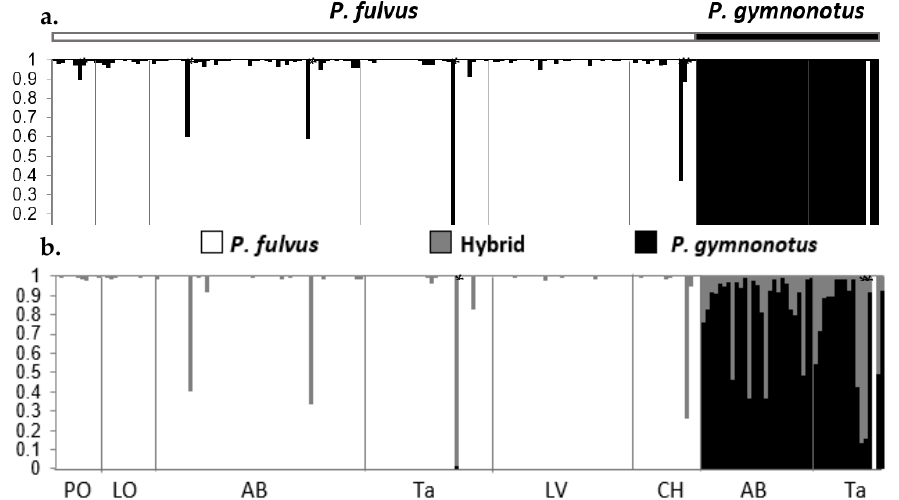
Figure 6. Microsatellite based species assignment of Pteronotus fulvus and P. gymnonotus samples by location ( a ). Results from the analysis in STRUCTURE (K2). ( b ). Assignment to species and hybrids obtained with NEWHYBRIDS. Each individual is represented by a vertical bar, in asterisks the individuals treated hybrids for each program and the abbreviations correspond to the locations presented in Table 1.